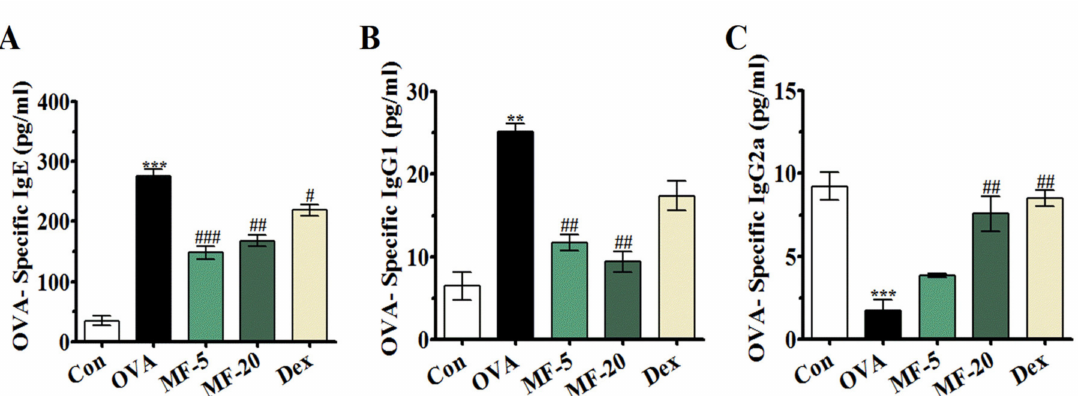
Figure 3. E ff ect of MF on the serum levels of OVA-specific IgE, IgG1 and IgG2a expressions in OVA-induced AR mice. The serum levels of OVA-specific IgE, IgG 1 , and OVA-specific IgG 2a . Values are presented as the mean ± SEMs ( n = 6 per group). ** p < 0.01, *** p < 0.001 , significantly di ff erent from the value of Control group. # p < 0.05, ## p < 0.01, ### p < 0.001 , significantly di ff erent from the value of OVA